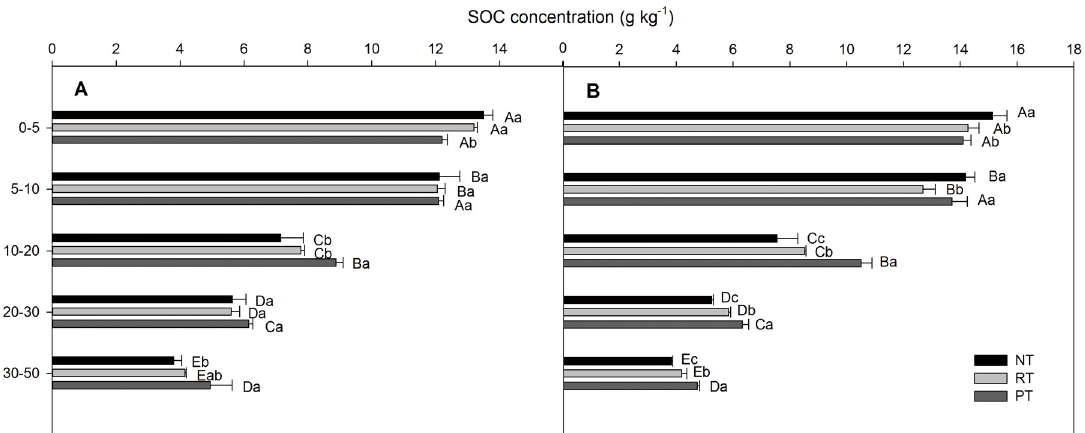
Fig 2. Depth distribution of the soil organic carbon (SOC) concentration under different tillage practices. No till (NT), rotary tillage (RT), and plow tillage (PT): (A) after the maize harvest and (B) after the wheat harvest. The data are presented as the means ± SD (n = 3). The various capital letters indicate significant differences among the soil depths, and the lowercase letters indicate significant differences among the treatments ( P < 0.05).